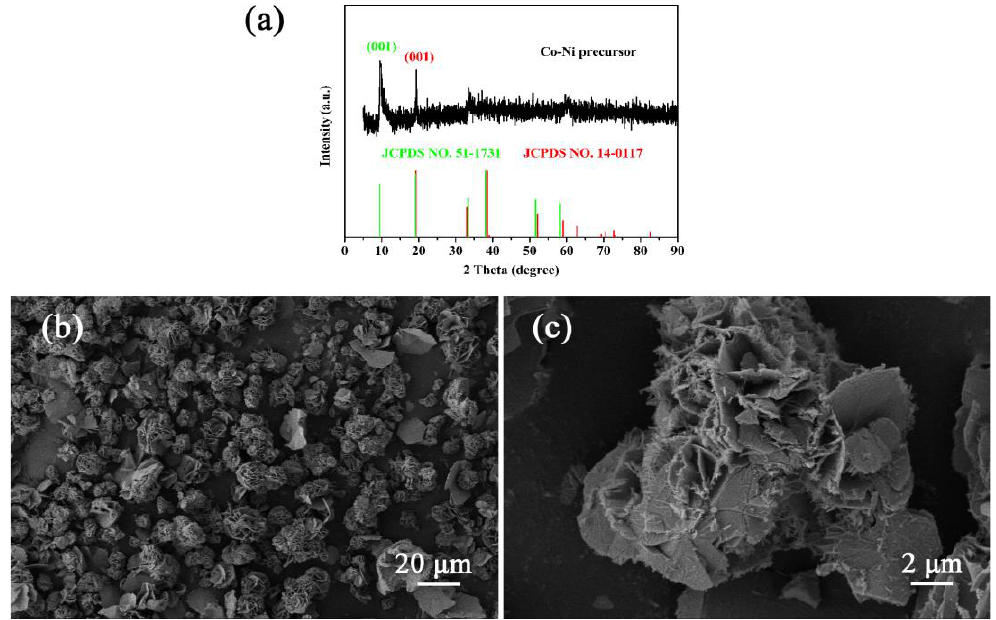
Figure 9. ( a ) XRD patterns of the cobalt-nickel precursor. ( b , c ) SEM images of the cobalt-nickel precursor.